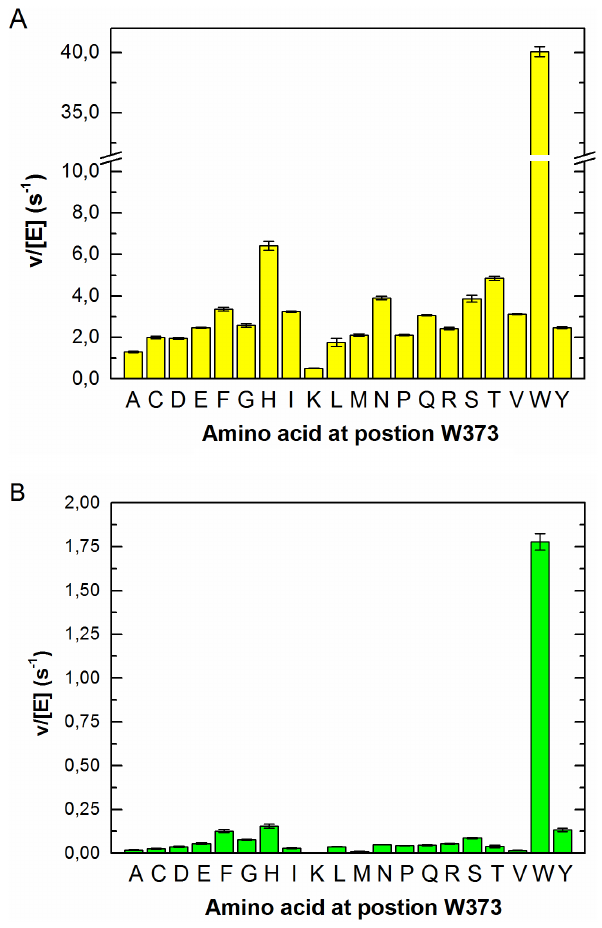
Figure 4. Hydrolysis rates for substrates p NPG (A) and t ZOG (B) by b -glucosidase Zm-p60.1 variants produced in the course of saturation mutagenesis of the W373position.